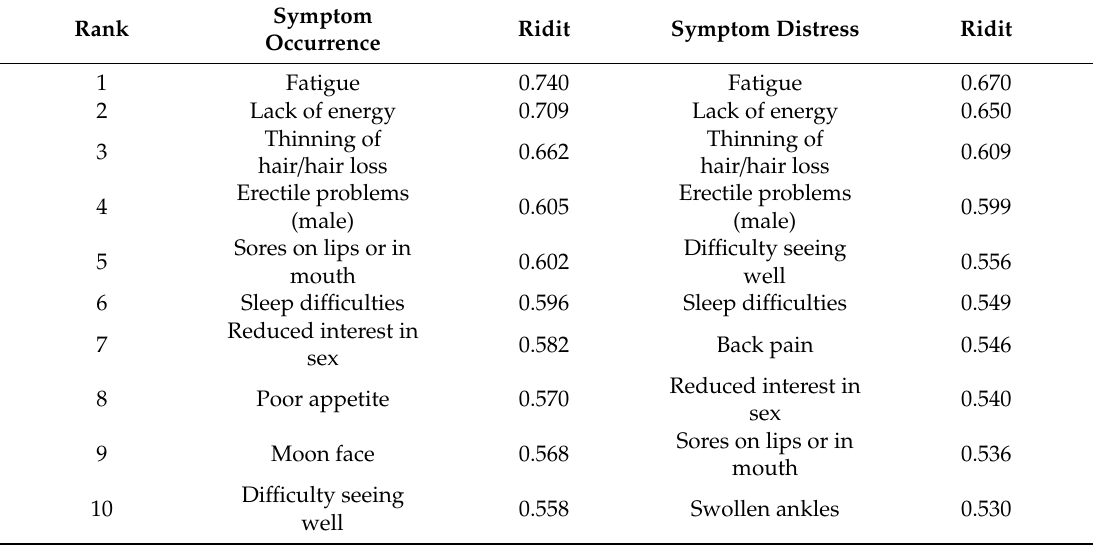
Table 4. The most frequent or distressing symptoms among kidney transplant